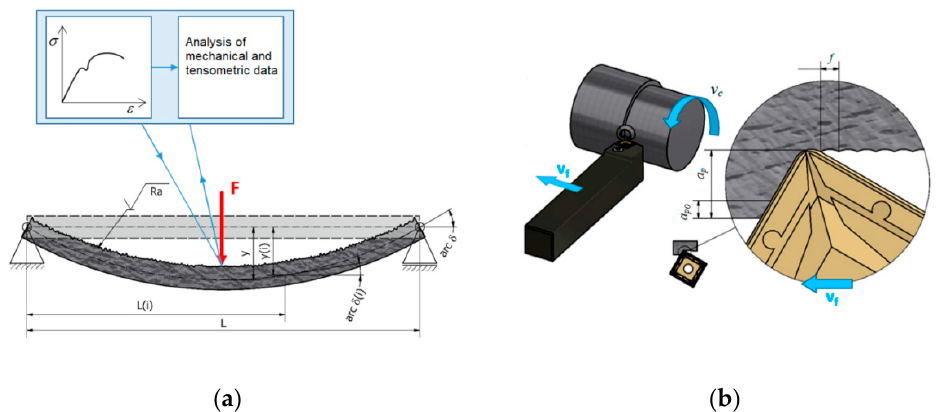
Figure 1. The physical nature is analogous to the beam curvature parameters. ( a ) in relation to fixed blade machining ( b ).